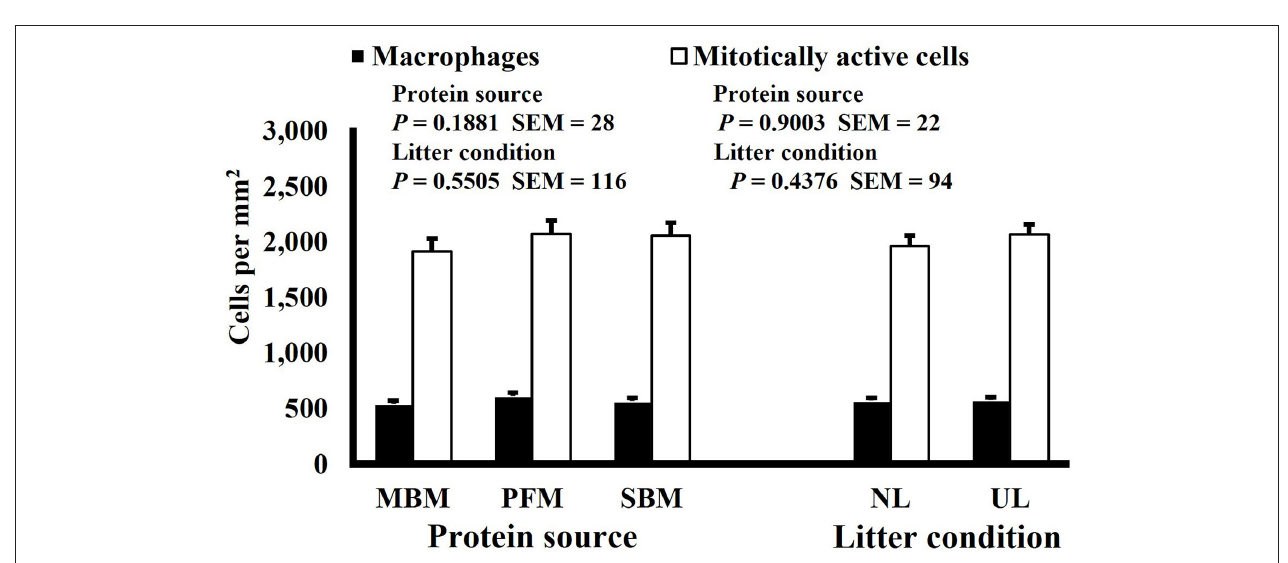
FIGURE 9 | Effect of dietary protein source and litter condition on macrophage (KUL01 + ) and mitotically active (BrdU + ) cell densities (cells per mm 2 ) in the ileum of 15-d-old broilers ( n = 36 per sampling d, 6 birds per treatment). MBM, meat and bone meal; PFM, 50% poultry by-product and 50% feather meal blend; SBM, soybean meal; NL, new litter; UL, used